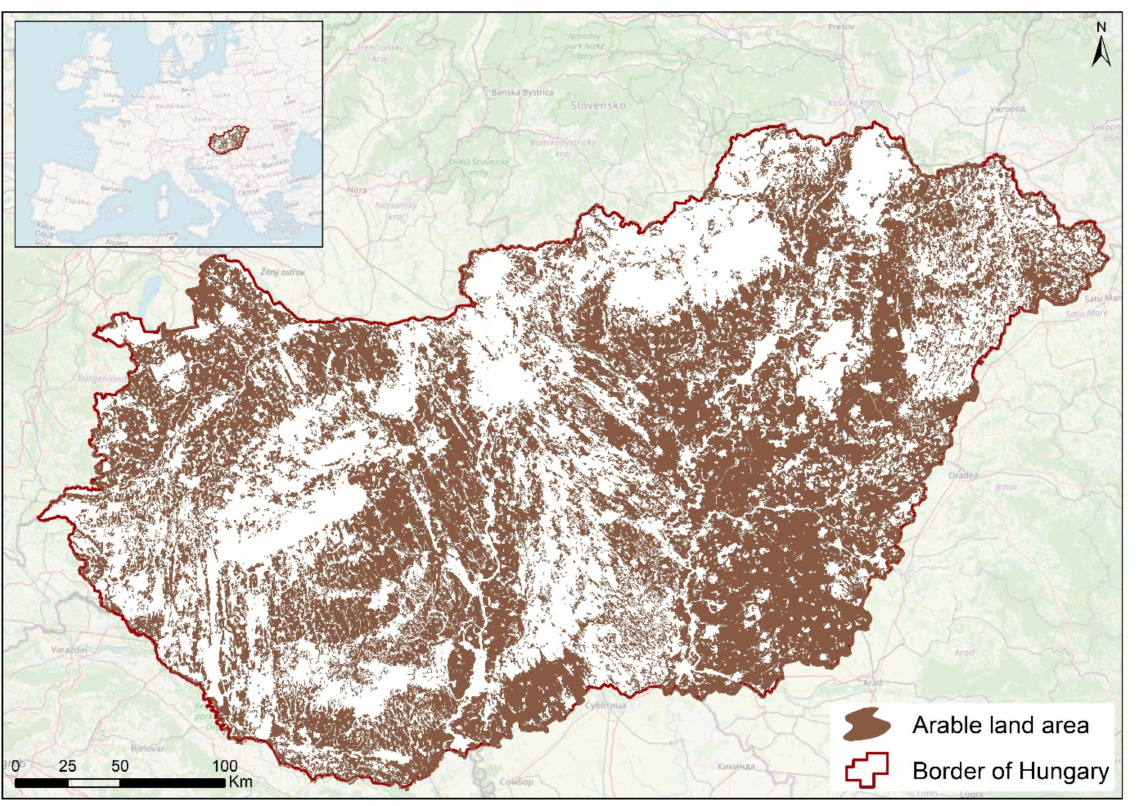
Figure 1. Arable land areas of Hungary (study area), based on Corine Land Cover 2018 dataset